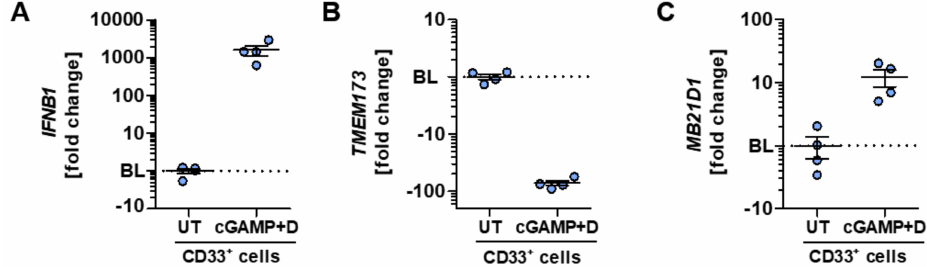
Figure 4. Highly STING-expressing myeloid cells exhibit a strong response to specific CDN stimulation. ( A – C ) CD33 + myeloid cells of HD were stimulated with 2 (cid:48) 3 (cid:48) -cGAMP plus digitonin (here defined as Cgamp + D group) or left untreated (UT) and afterward analyzed for the expression of genes belonging to the STING / IFN- β -axis. Gene expression analysis of IFNB1 ( A ), TMEM173 ( B ), or MB21D1 ( C ) are shown as fold change relative to the untreated control after 4 h of stimulation. In (A–C), the mean corresponding ∆∆ C t value of the control group was normalized to 1 and set as the BL (displayed as dotted line), thus serving as a reference. Each data point represents an individual HD. Data were compiled from four independent